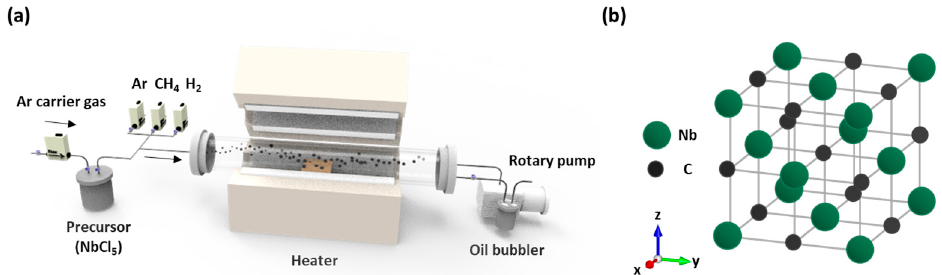
Figure 1. ( a ) Schematic of the chemical vapor deposition (CVD) reaction system; ( b ) Crystal structure of